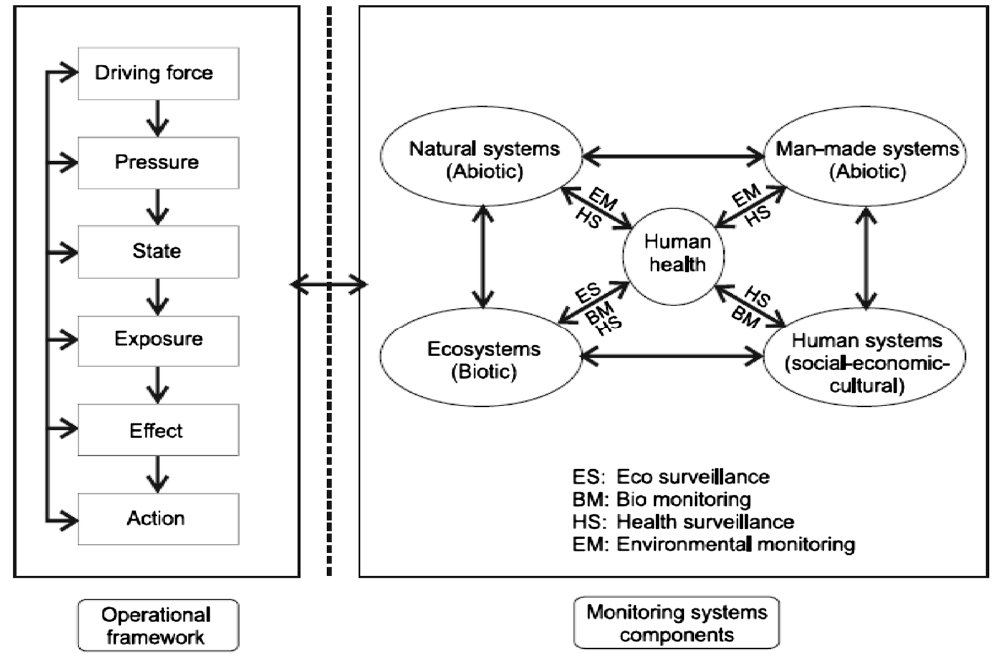
Figure 2. A conceptual framework for integrated environmental health monitoring [19].